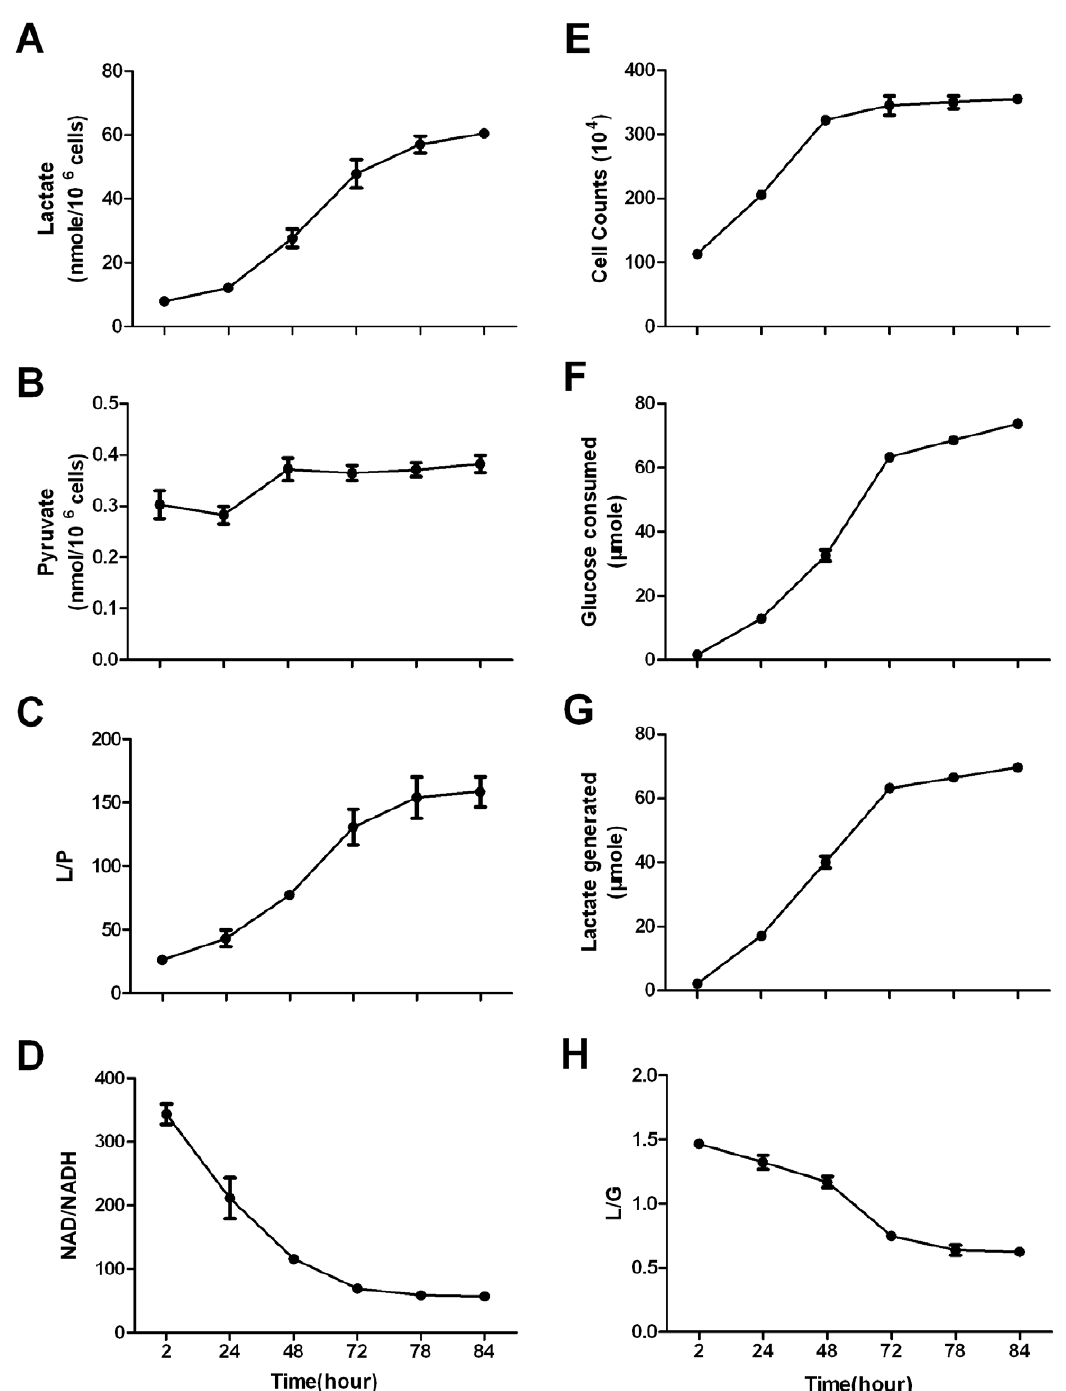
Figure 1. Intracellular lactate concentration and L/P ratio are highly labile in Bcap-37 cells. Bcap-37 cells were incubated in complete RPMI-1640 medium containing 12 mM glucose and supplemented with 6 mM glucose every 24 hours. At the indicated time point, intracellular lactate and pyruvate, glucose consumption and lactate generation by Bcap-37 cells, and cell growth were monitored. (A) Intracellular lactate; (B) Intracellular pyruvate; (C) Intracellular L/P ratio; (D) Cytosolic free NAD/NADH ratio erroneously estimated from the corresponding L/P ratio; (E) Cell proliferation curves; (F) Glucose consumption; (G) Lactate generation; (H) L/G ratio (the generated lactate divided by the consumed glucose between 2 time points). Data are mean 6 SD. Data were confirmed by 2 independent experiments. doi:10.1371/journal.pone.0034525.g001 cancer cells in culture produce quantity of lactate, reflecting that equilibrium in cells, lactate accumulation would eventually bring the net flow of the intracellular conversion is from pyruvate to the conversion to equilibrium. In order to test this hypothesis, we lactate. On the other hand, considering the conversion is at near- incubated cells in culture medium supplemented with serial